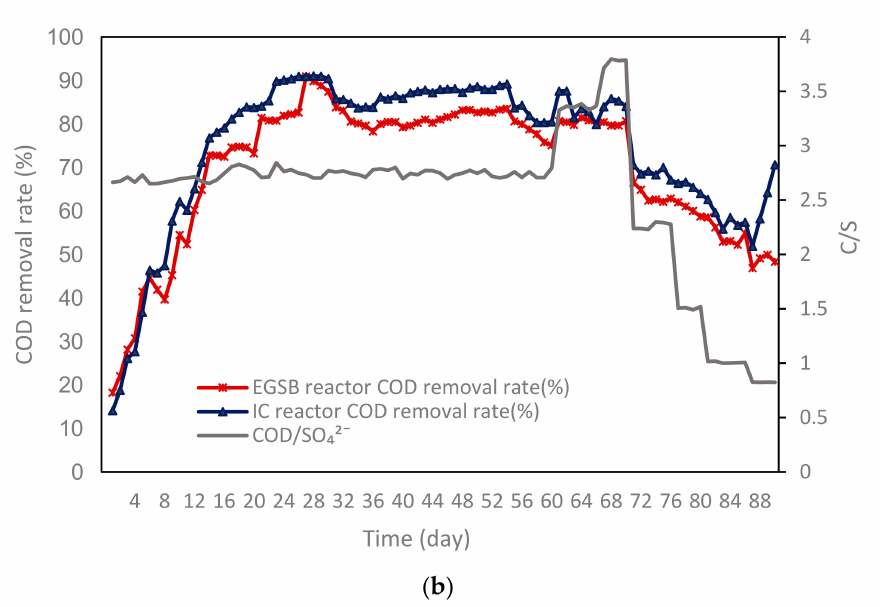
Figure 6. Relationship between C/S and COD removal and the comparison of two reactors. ( a ) Relationship between C/S and COD concentration of reactor effluent and the comparison of two reactors. ( b ) Relationship between C/S and COD removal rate of reactor and the comparison of two